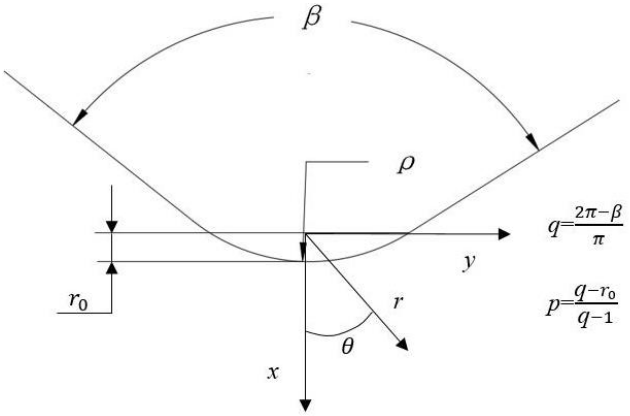
Figure 4. Schematic of a local area of the V-shaped notch.